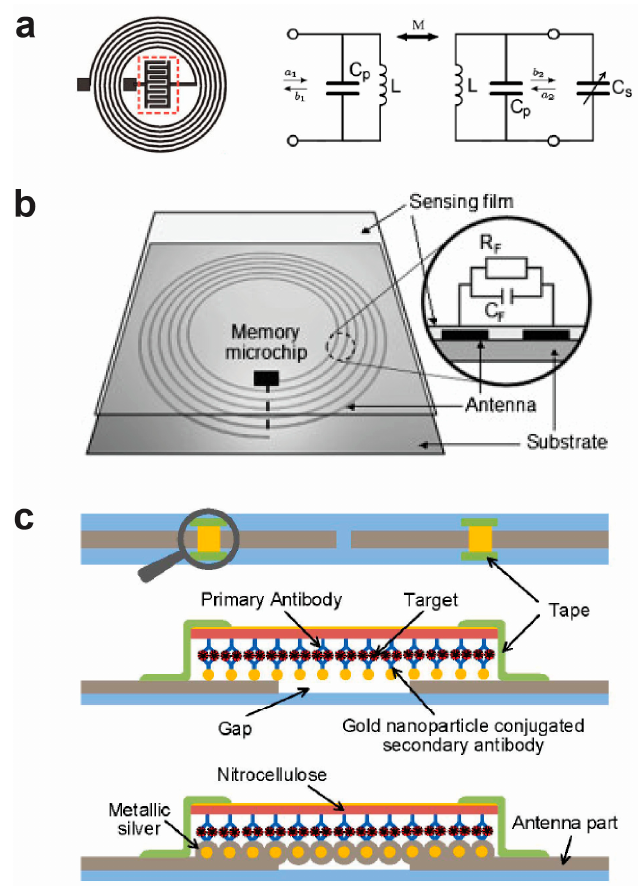
Figure 1. Wireless inductor-based wireless bioelectronic sensors. ( a ) Inductor-capacitor elements (left) and equivalent circuit model of the inductor-capacitor sensor (right). Reprinted with permission from [60]. Copyright (2013) Wiley. ( b ) LC tag connected to a memory microchip. Reprinted with permission from [62]. Copyright (2009) Wiley. ( c ) The silver enhancement process for a dipole antenna biosensor. Reprinted with permission from [57]. Copyright (2015) IEEE.